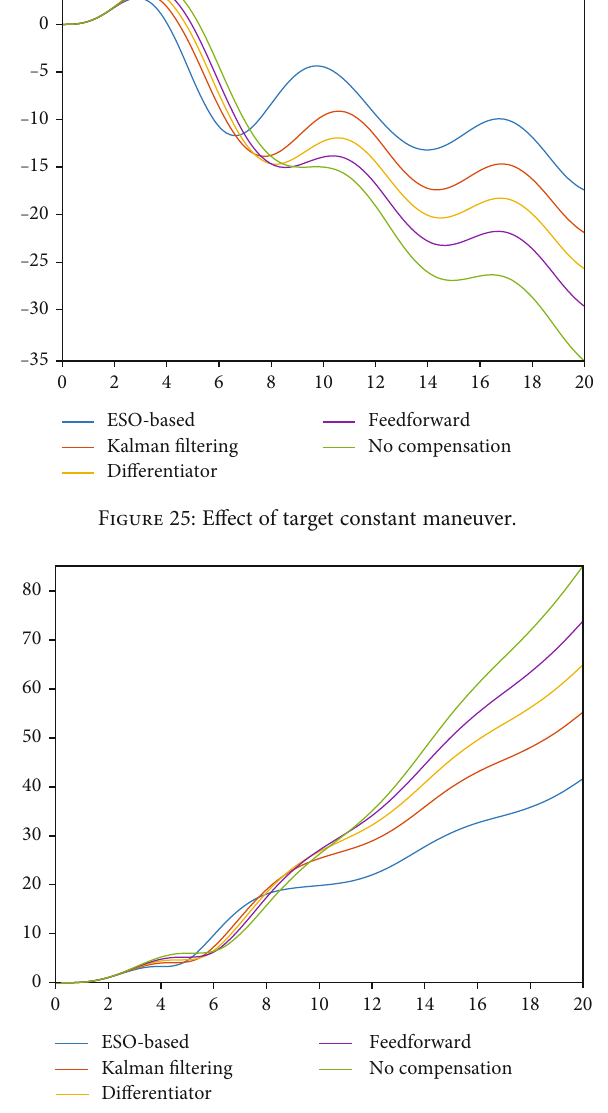
Figure 26: E ff ect of target random maneuver.